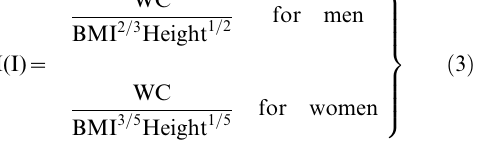
Table 2. Weight status in 2000.